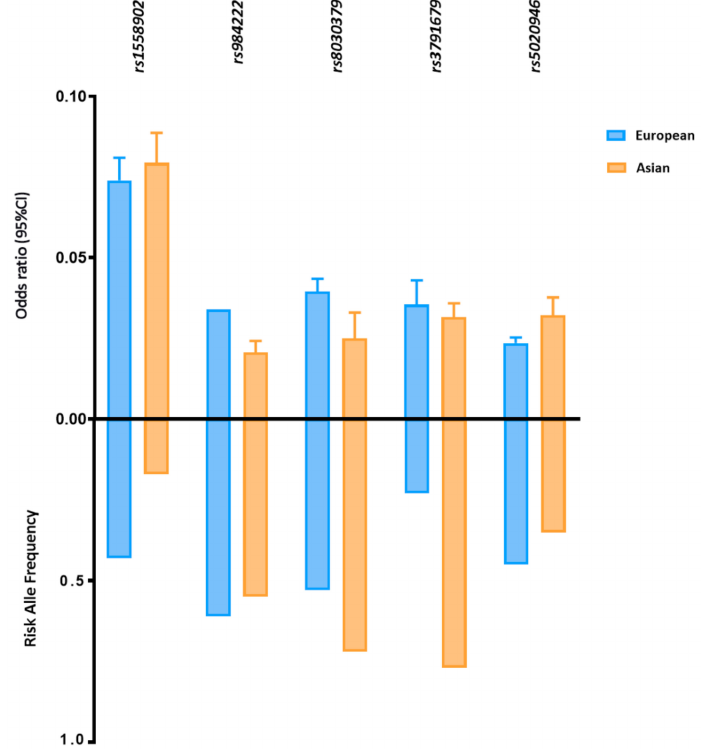
Figure 2. Risk allele frequency and effect size of FD-related loci in European and Asian populations. Risk allele frequency and effect size of fat distribution-related susceptibility loci with genome associ- ation significant p value in European and Asian cohorts. Fat distribution-related loci are shown in this figure with a p < 5 × 10 − 8 in both cohorts. P values and effect size are according to the reference studies reported in (Supplementary Table S1). The allele frequency is based on the 1000 Genomes Project